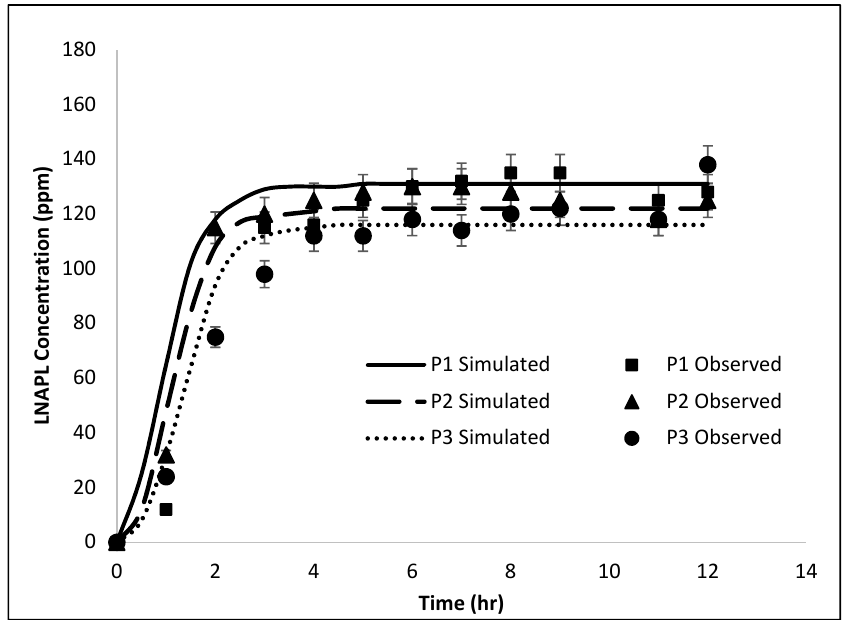
Figure 3. Concentration of NAPL at sampling ports P1, P2, and P3 of column setup at soil-water temperature of 28 °C.